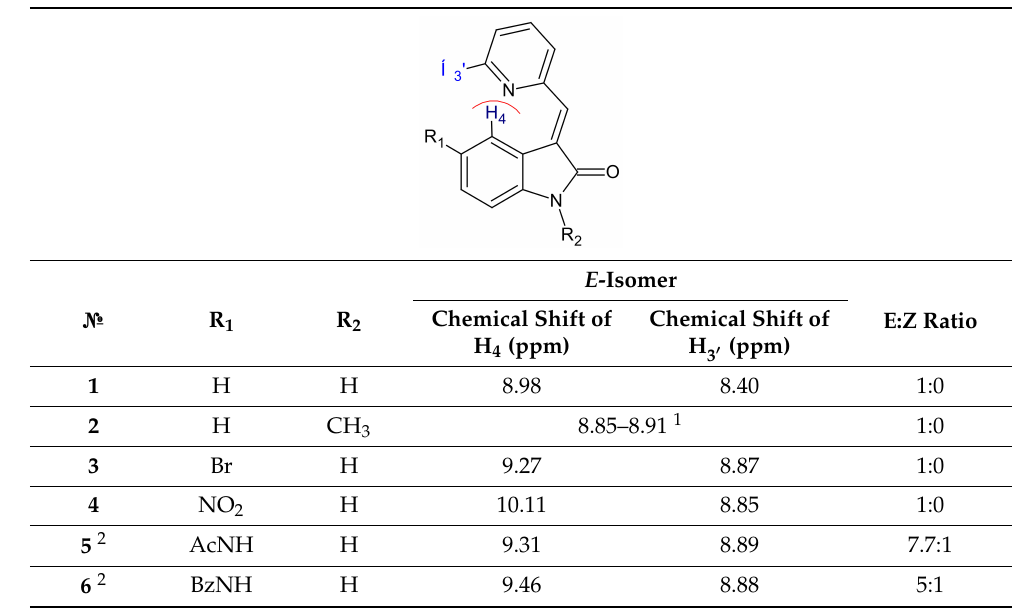
Table 2. Preferred configuration of 3-(pyridin-2-ylmethylidene)-2-oxindoles and corresponding characteristic chemical shifts.